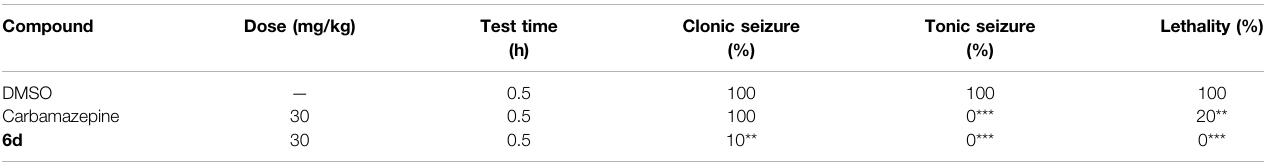
TABLE 4 | Ef fi cacy of compound 6d on bicuculline-induced seizures in mice. Compound